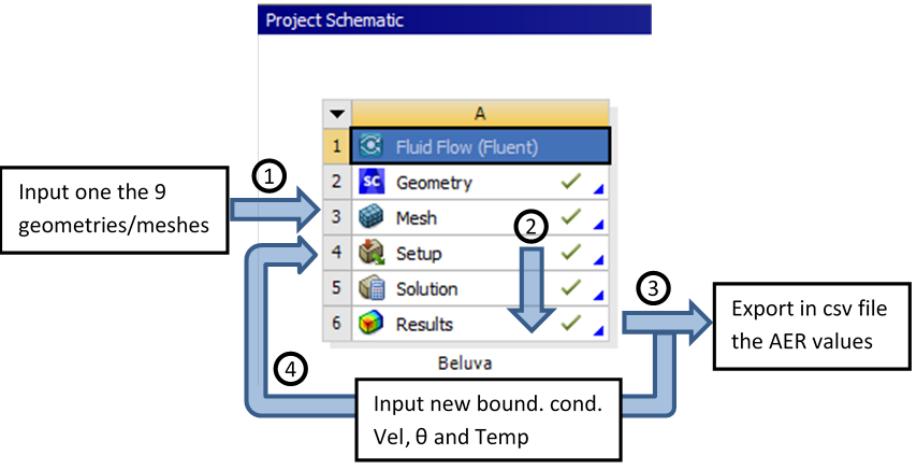
Figure 4. Description of automatizing process in four steps under Ansys coupled with